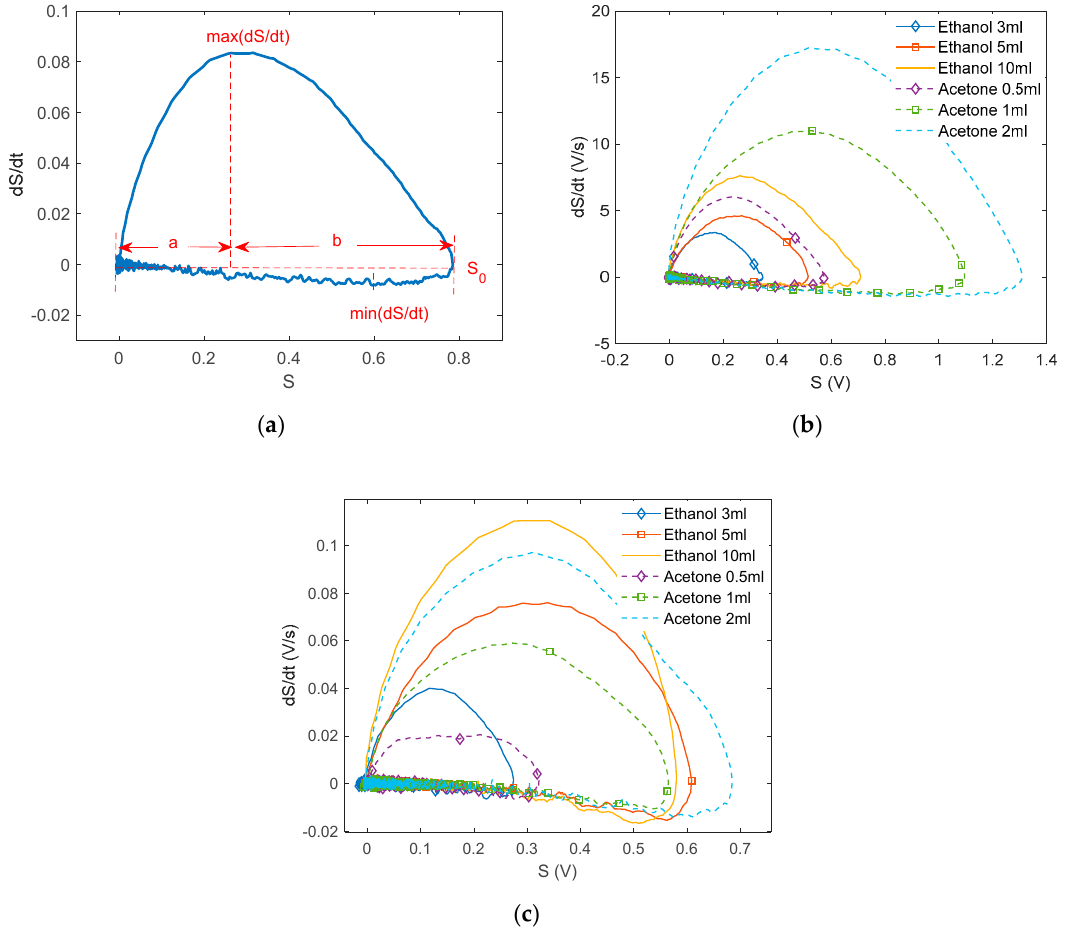
Figure 5. ( a ) Representative response curve of a MOS sensor and its extracted parameters in phase space; and using ( b ) TGS 2602, ( c ) MQ 136, the obtained response curve to different amounts of ethanol and acetone in phase space. Solid line represents ethanol; dotted line represents acetone.